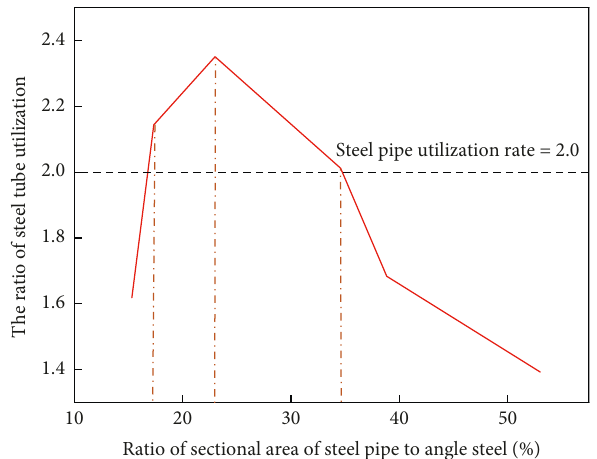
Figure 15: Utilization ratio curve of the steel pipe.